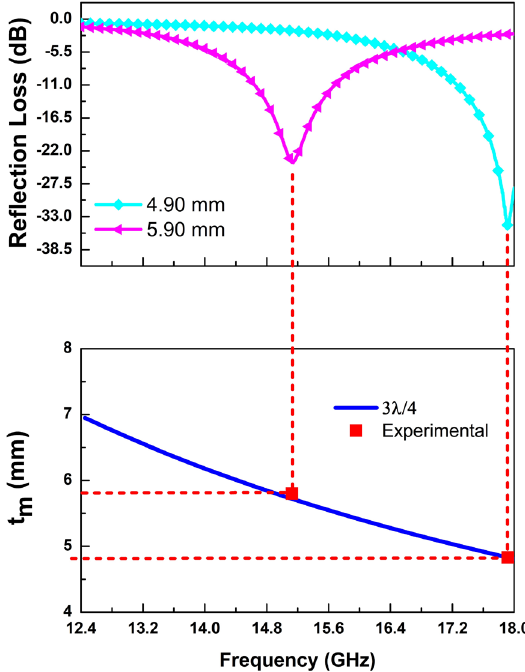
Figure 4. Sample 20PC+0.2CNT thickness of reflection loss corresponding to calculated t m